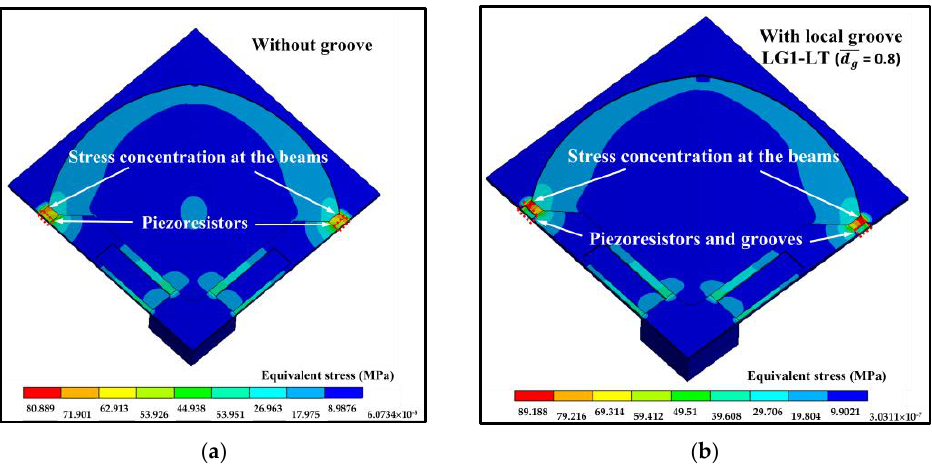
Figure 6. Equivalent stress distributions at the applied pressure of 5 kPa: ( a ) sensor without groove